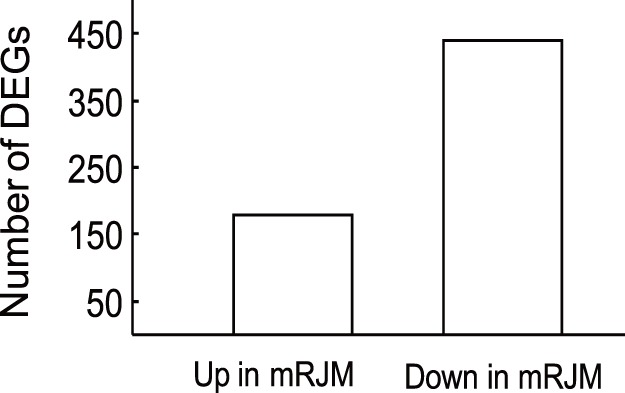
Differential expression analysis of genes in mRJM.Expression levels were considered different if the threshold of false discovery rate (FDR was 0.001 and the absolute value of log2 Ratio was 1).